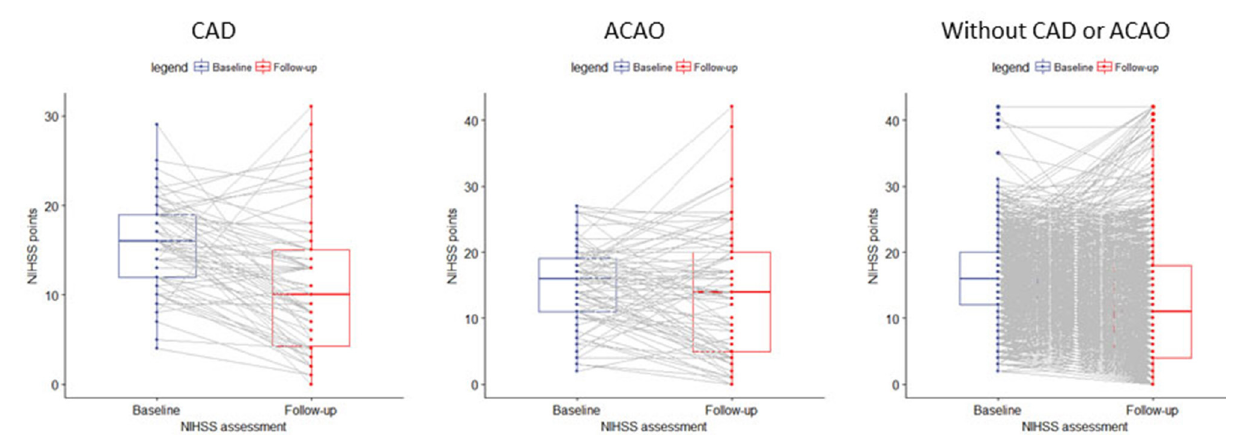
FIGURE 2 | Paired boxplot of NIHSS points at baseline and follow-up.